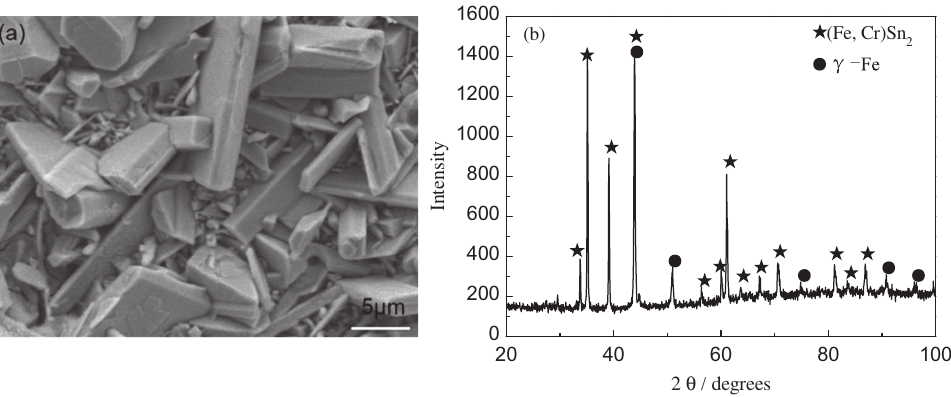
Figure 1: SEM micrograph and XRD pattern of (Fe, Cr)Sn 2 layer on 304 stainless steel before oxidation: (a) morphology of (Fe, Cr)Sn 2 layer after dissolution of surface Sn adhesion, (b) XRD pattern of the (Fe, Cr)Sn 2 layer.